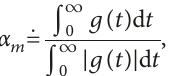
Figure 1. The step response of the considered system for α � 1 is represented in the dashed line.